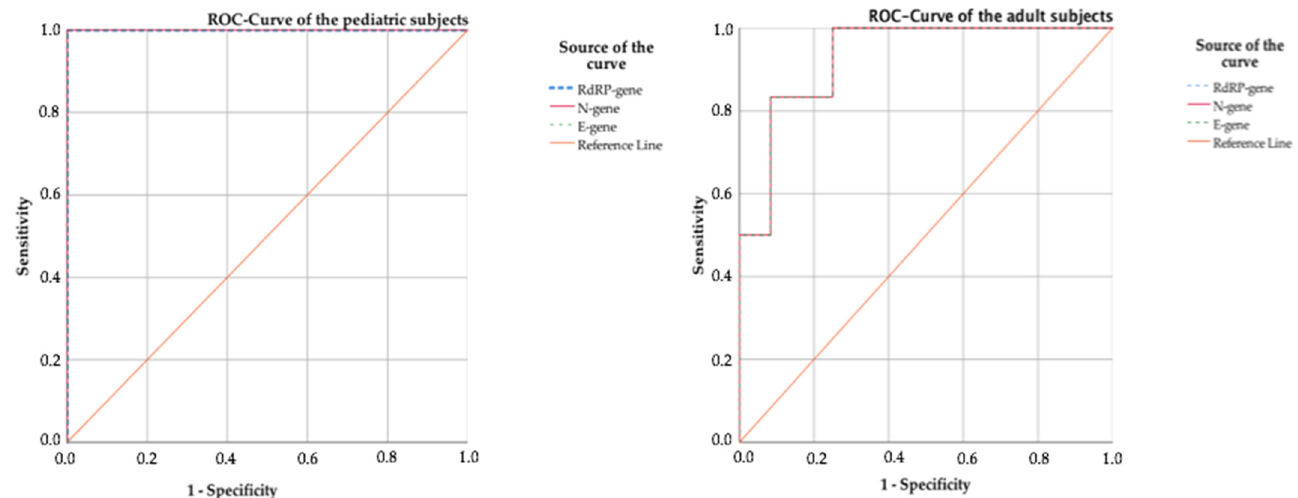
Figure A3. ROC curves of the different Ct-values for the pediatric and adult subjects.